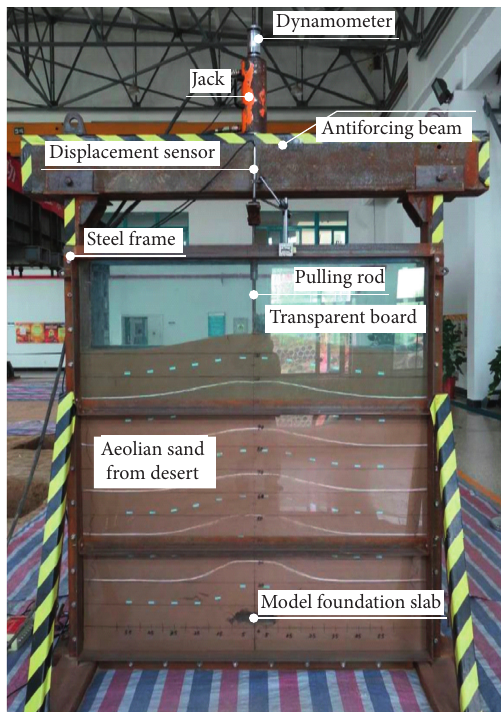
Figure 2: Model tank and foundation model.